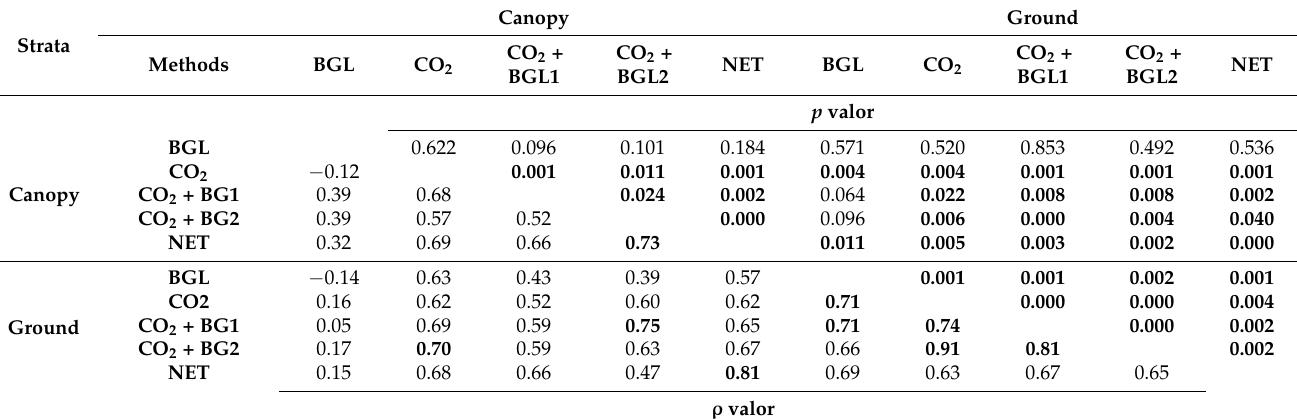
Table 3. Spearman’s correlation coefficients ( ρ ) and statistical significance ( p ) values from the pair-to- pair comparison between different methods (stratum–technique–attractant) for mosquito collection in the “P é -do-Gigante” sector of the Vassununga State